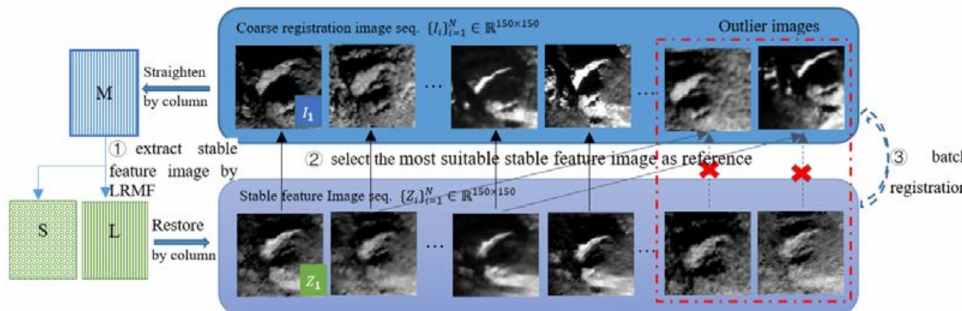
Figure 3. Flowchart of the LRC-BRE (note: the batch registration step is not necessary for batch reference extraction, which is mainly considered for ablation